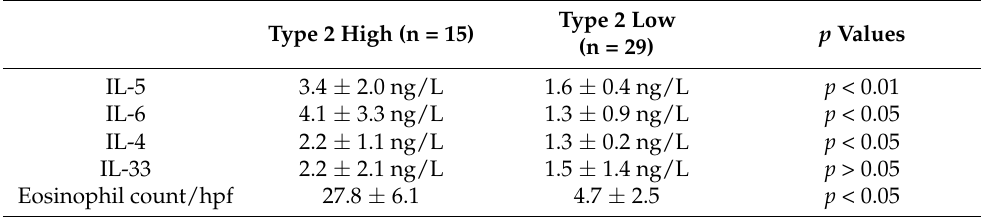
Table 2. Levels of cytokines in the two groups. Values are reported as mean ± standard deviation. The right column shows the p -value of t -test comparison between the two